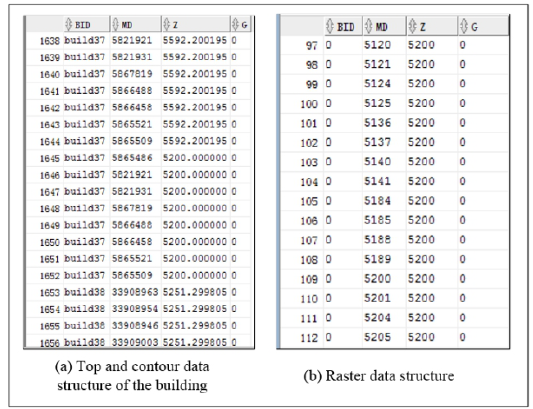
Figure 7. Vector and raster Data